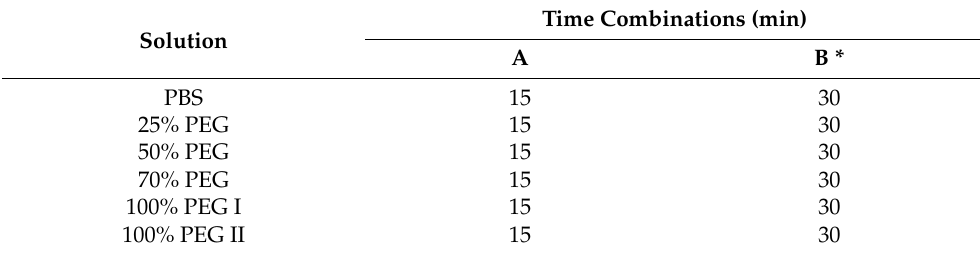
Table 4. Summary of method 2 in PEG processing.